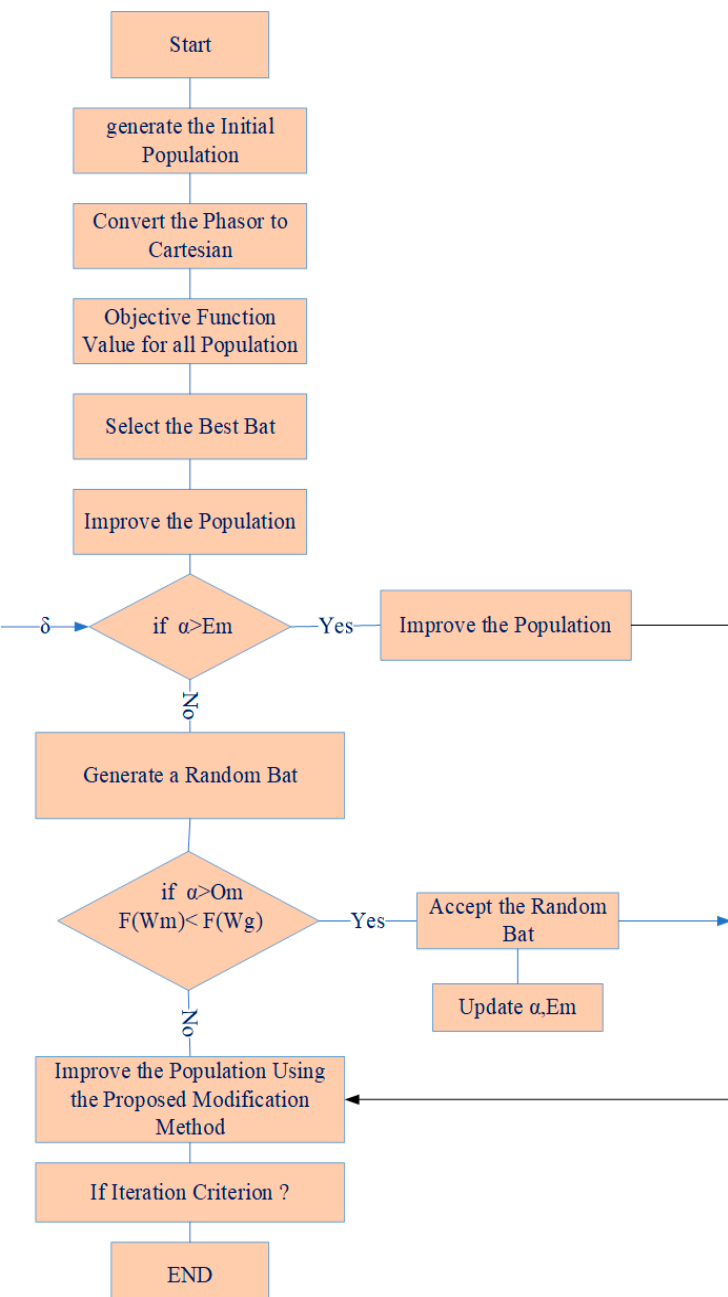
Figure 2. The bat optimization algorithm’s performance.